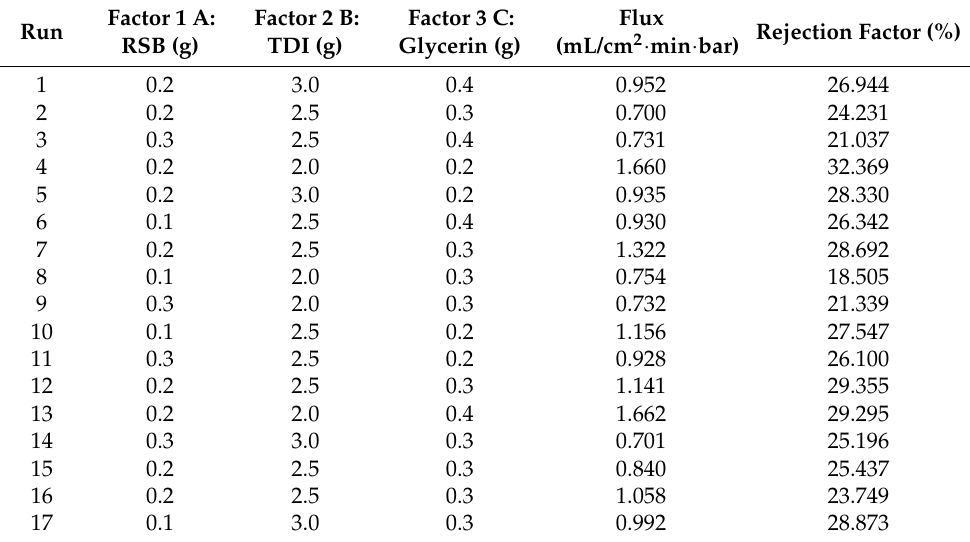
Table 2. The result of decreased ammonia levels from the filtration